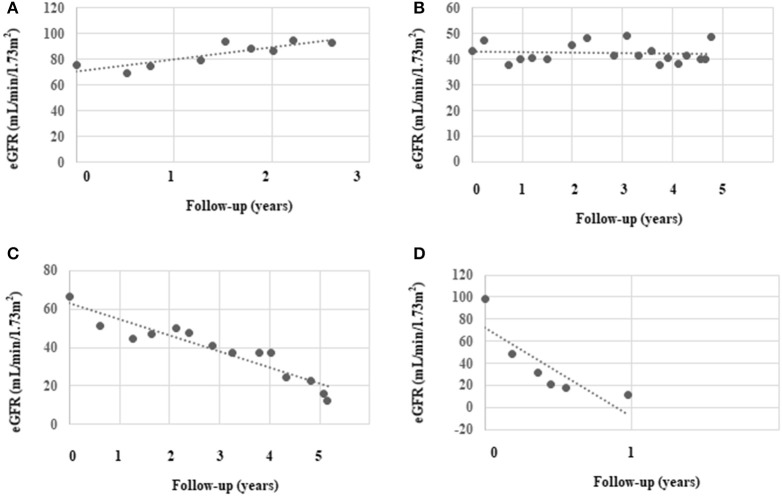
Classical eGFR decline patterns identified in the study. We chose four representative patients from the study cohort to depict their patterns of eGFR decline: (A) slow increase in eGFR, (B) stable eGFR, (C) slow decline in eGFR, and (D) rapid decline in eGFR. The black dots represent individual measurements and the dashed lines summarize the trend for each patient.